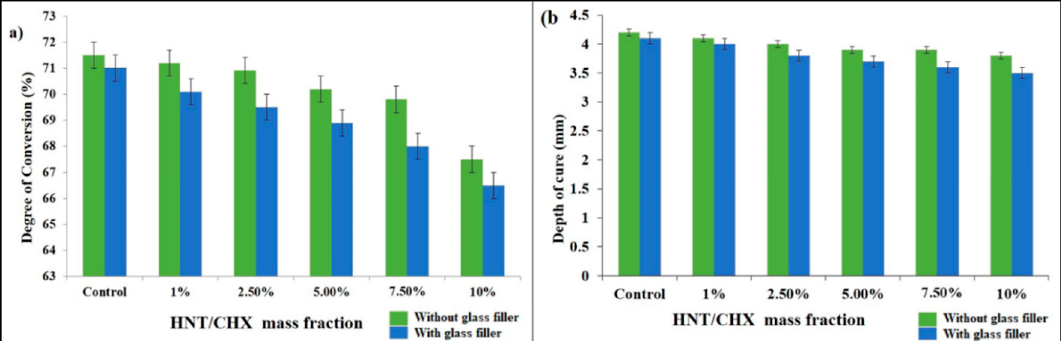
Figure 5. ( a ) Degree of conversion and ( b ) depth of cure of resin composites with varied amounts of HNT/CHX (1%, 2.5%, 5%, 7.5% and 10 wt.%) ( p < 0.05).